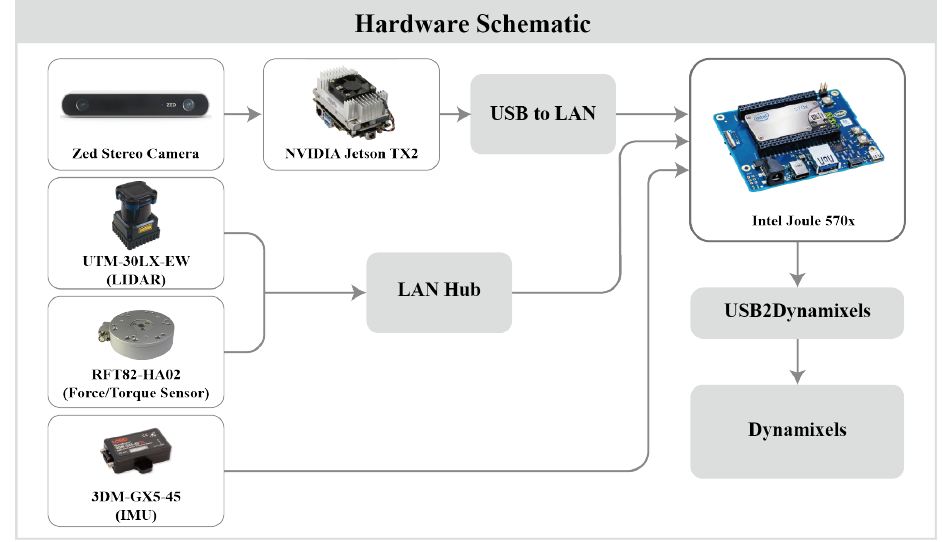
Figure 5. Electrical component diagram of skiing robot